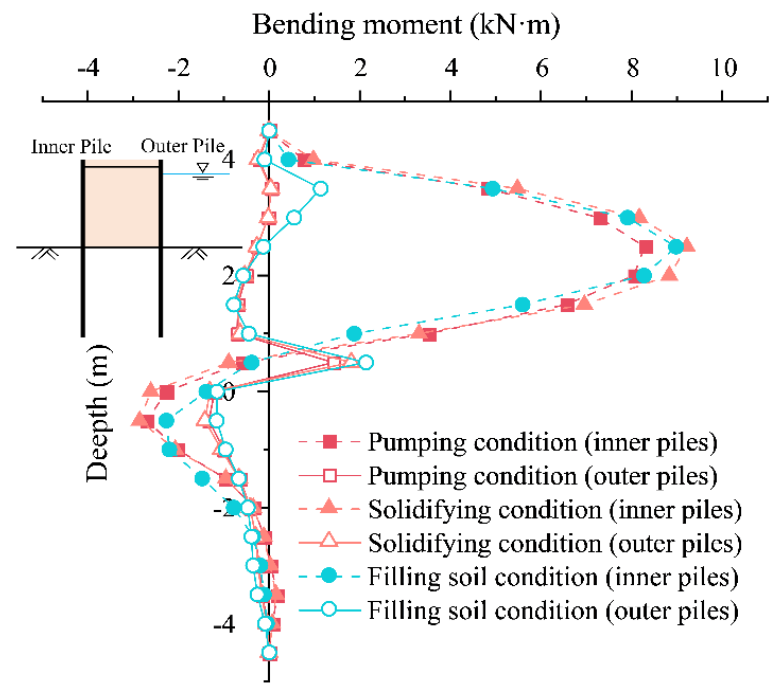
Figure 10. Horizontal displacement curve of piles at different stages.